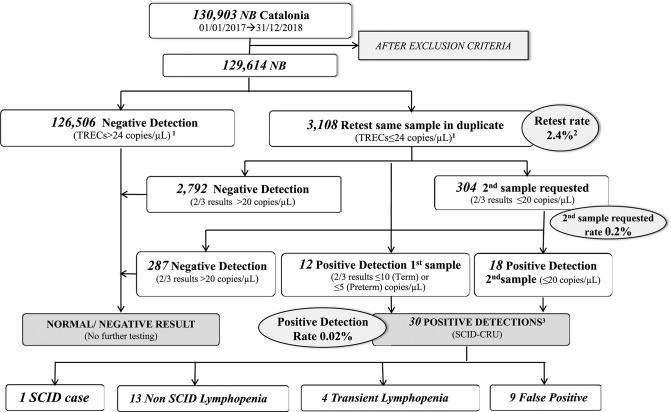
Results of SCID NBS in Catalonia over the study period (2017–2018). 12018 cutoff (2017 cutoff = 34 copies/μL); 22017+2018-Retest rate 2017-Retest rate = 3.34% (cutoff = 34 copies/μL); 2018-Retest rate = 1.4% (cutoff = 24 copies/μL); 3Three patients are currently under study. NB, newborns; SCID, severe combined immunodeficiency; SCID-CRU, SCID Clinical Reference Unit.